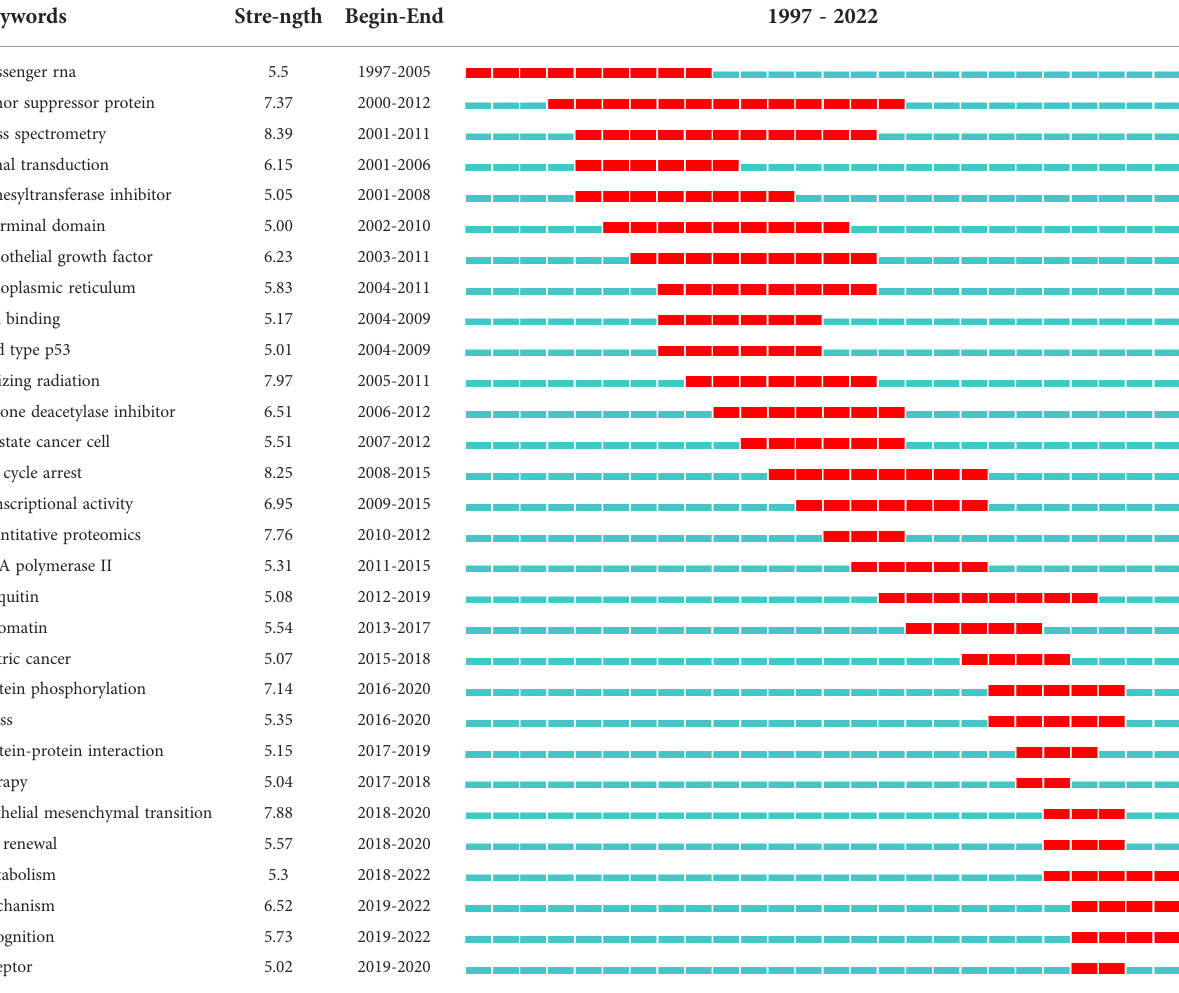
TABLE 5 The top 30 Keywords with the Strongest Citation